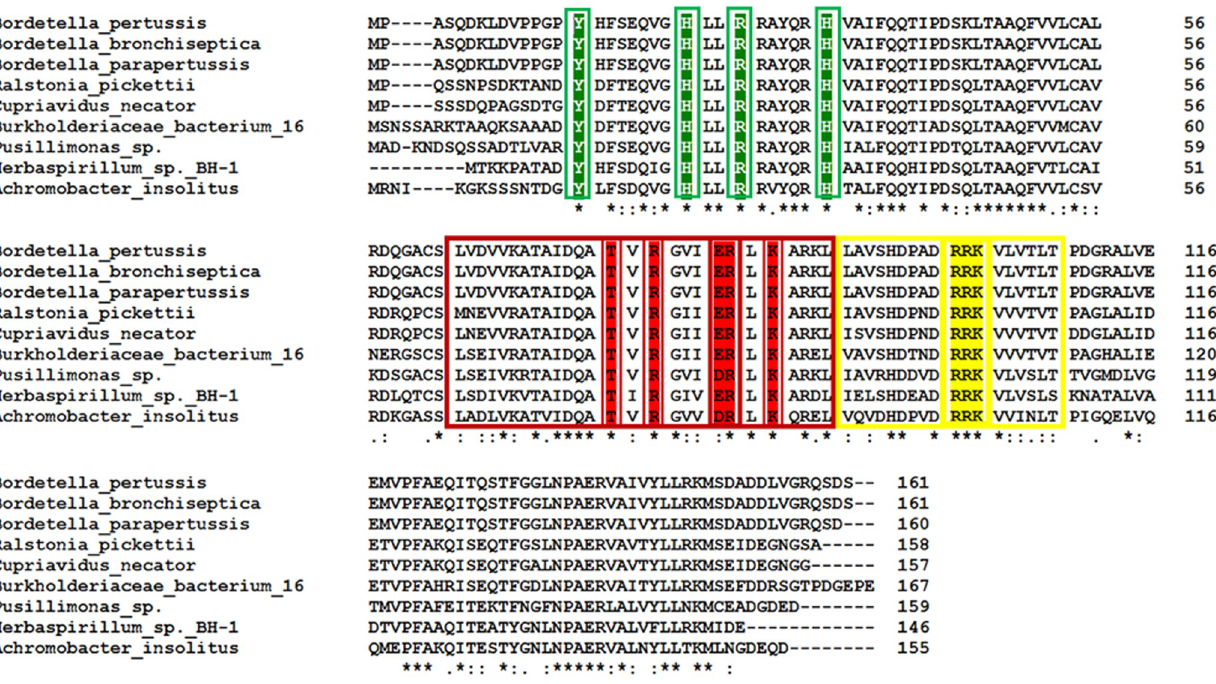
Fig 5. BpsR homologs retain 6HNA binding residues. An amino acid sequence alignment of BpsR homologs from other Gram negative bacteria (Clustal Omega [44]) with an overall sequence identity of about 40%. The residues highlighted in red and yellow boxes are in the HTH and wing domains, respectively. The amino acids highlighted in green are the residues that make up the 6-HNA binding pocket. These residues have 100% identity across the indicated species.